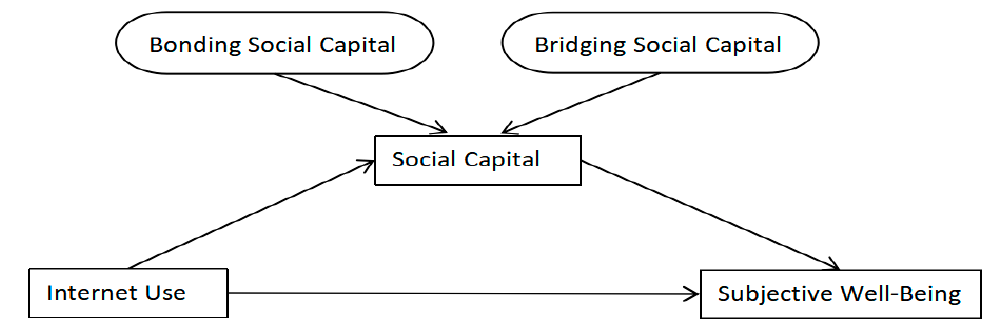
Figure 1. Theoretical schematic diagram of the core variable.